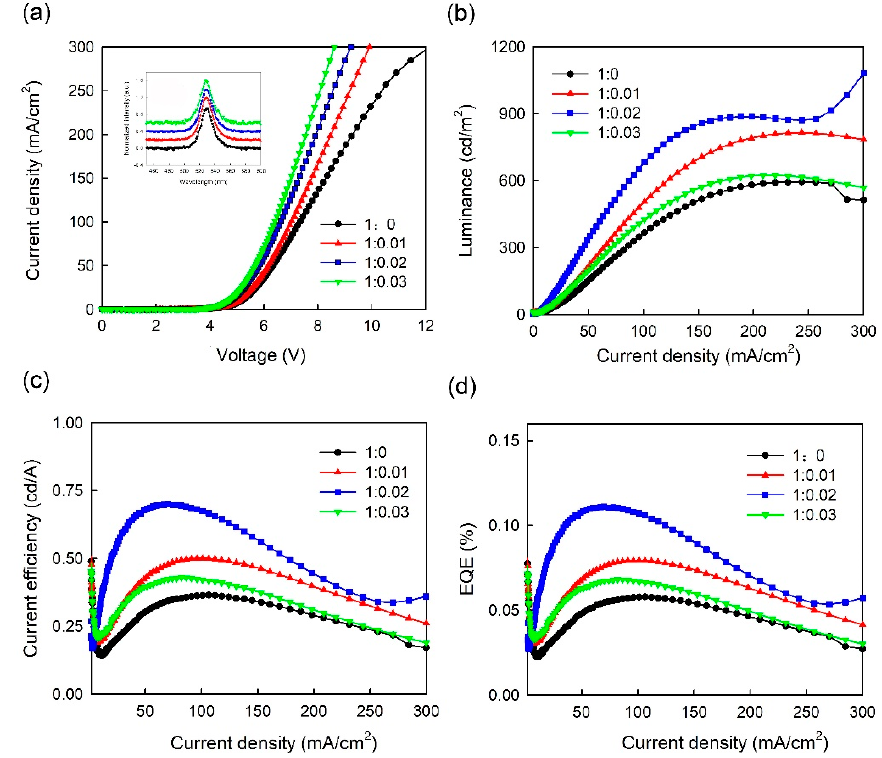
Figure 5. ( a ) J-V, ( b ) L-J, ( c ) CE-J, ( d ) EQE-J curves of PeLEDs with a one-step spin-coated emitter and a PEDOT:PSS/MoO 3 -ammonia (1:0, 1:0.01, 1:0.02, 1:0.03) composite HTL (device S1, S2, S3, S4). The inset is normalized EL spectra of the PeLED devices at 20 mA/cm 2 , which were shifted vertically for clarity. Table 1. Summary of the device parameters of PeLEDs (device S1, S2, S3, S4) with a single-step spin-coated emitter and a PEDOT:PSS / MoO 3 -ammonia (1:0, 1:0.01, 1:0,02, 1:0.03) composite HTL.